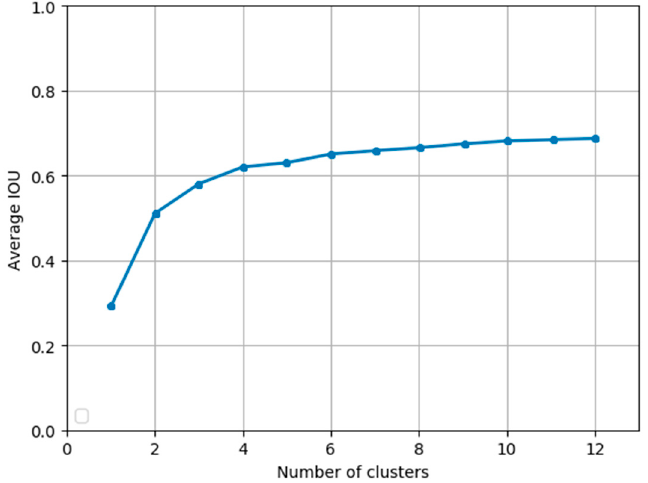
Figure 5. The relationship between the number of clusters and average IOU by K-means